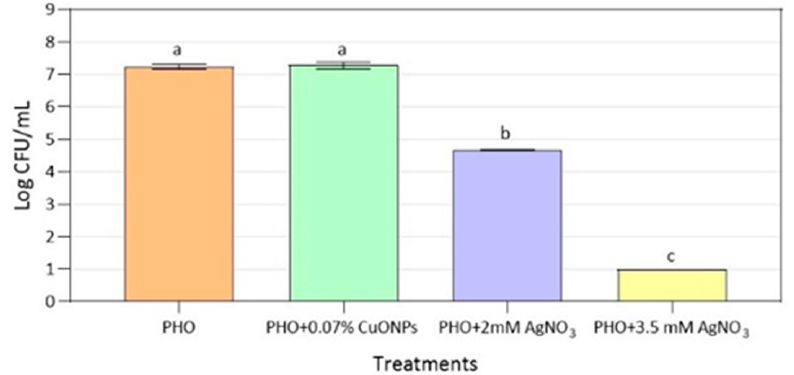
Figure 2. Antibacterial activity against MRSA of PHO films with different concentrations of metal nanoparticles. The detection limit was 10 CFU/mL. Significant differences ( p < 0.05) are symbolized with different letters (a–c).